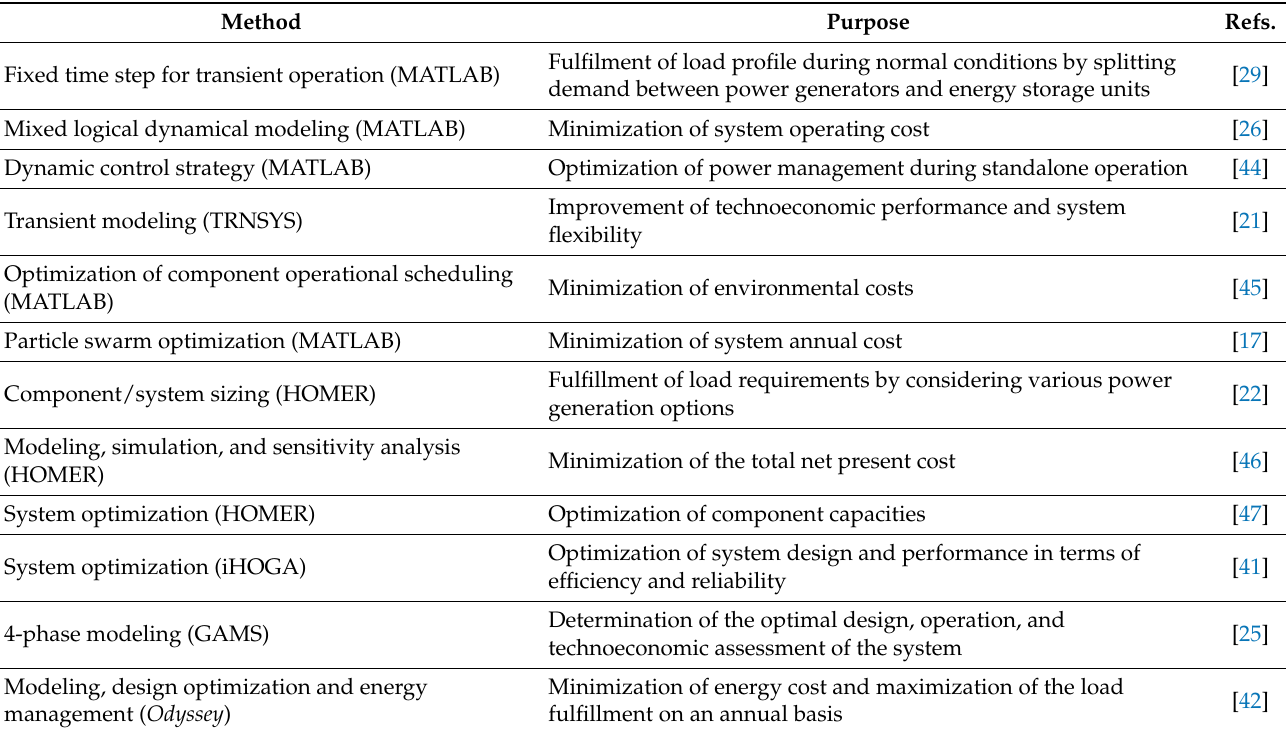
Table 1. Modeling and optimization methods for hybrid PV-RHFC microgrid